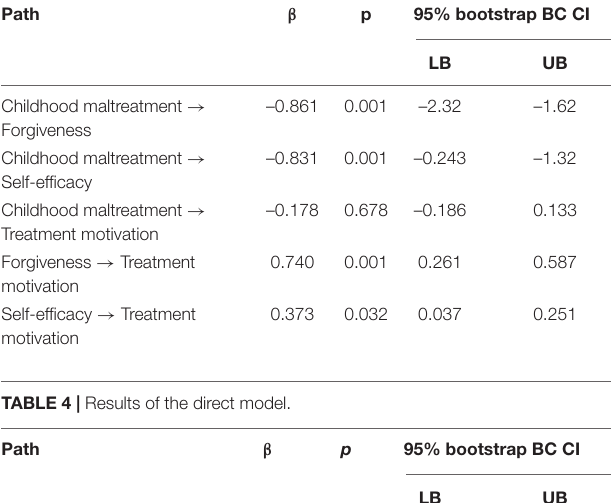
TABLE 3 | The regression path coefficient.